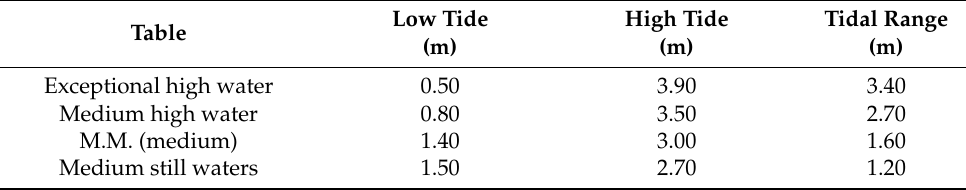
Table 1. Tidal levels in the study area.